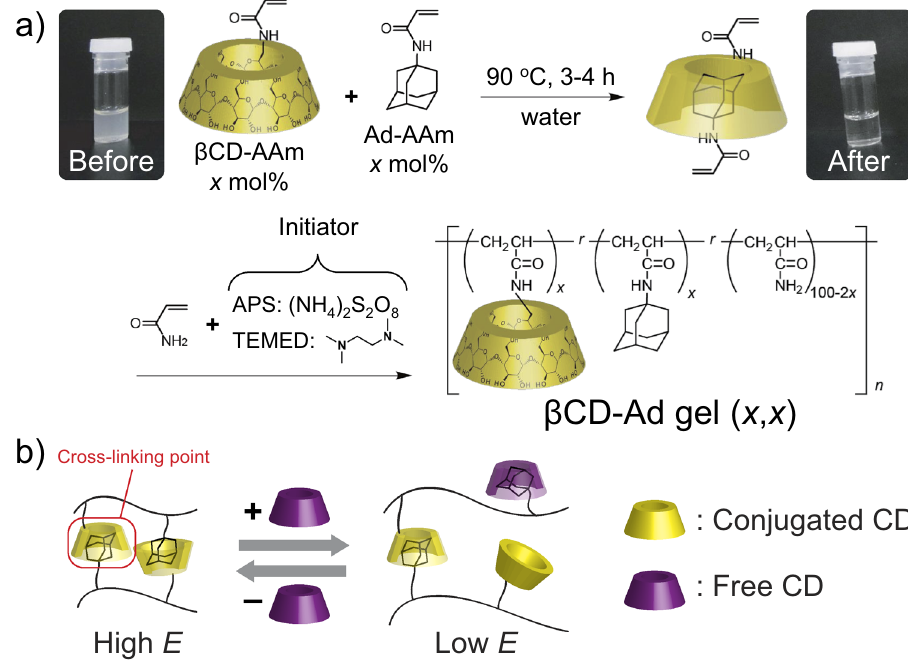
Figure 1. Working principle of host-guest gel. ( a ) Preparation and chemical structure of β CD–Ad gel ( x , x ). x represents the mol% contents of β CD and Ad units. ( b ) Reversible switching of β CD–Ad bonds in response to free β CD molecules (purple) in solution. Under equilibrium, the fraction of β CD–Ad bonds connected to the polymer chains depends on β CD concentration, which allows for the dynamic modulation of Young’s modulus E